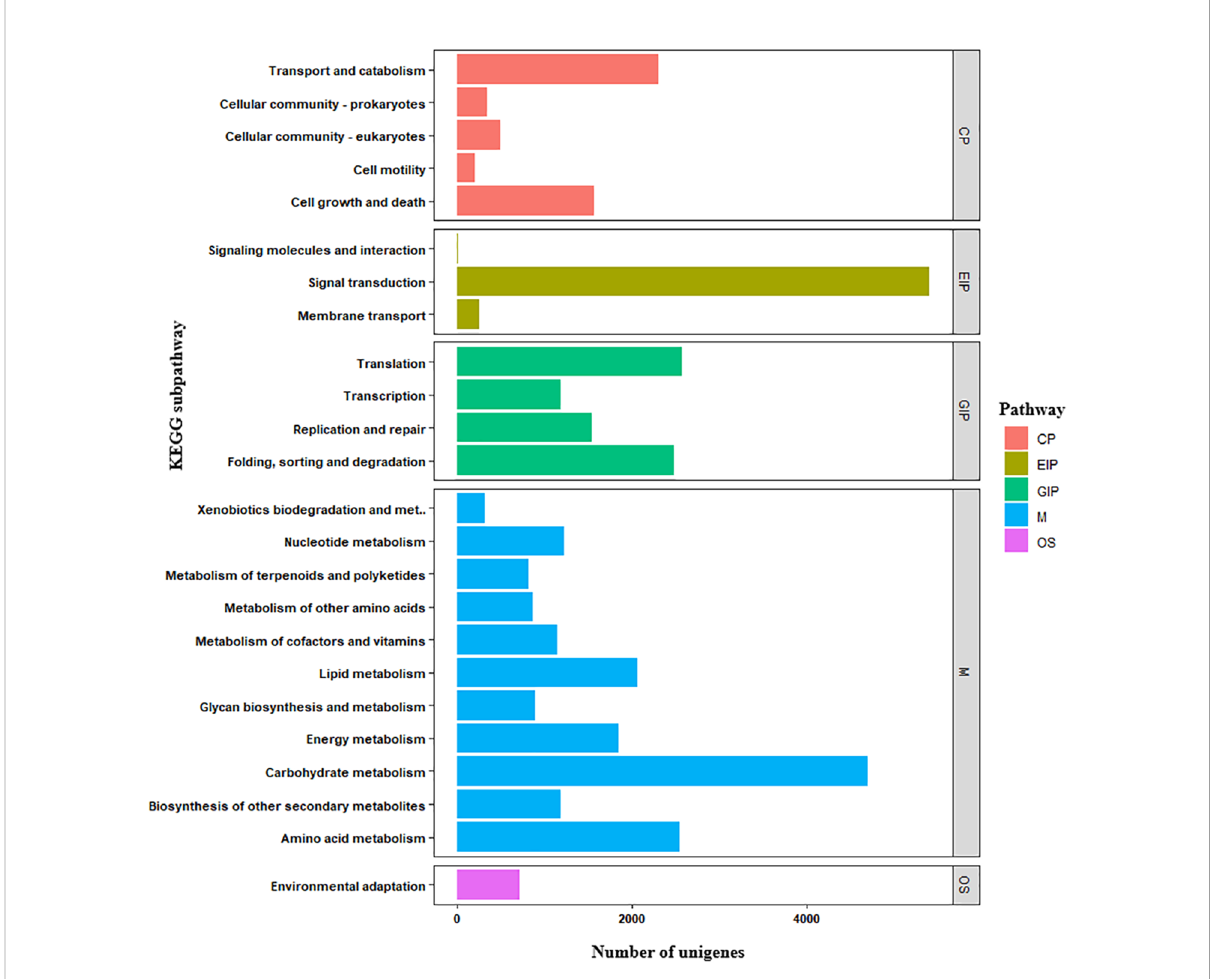
FIGURE 5 Kyoto Encyclopedia of Genes and Genomes (KEGG) annotation of fi nger millet unigenes in to different pathway categories. X-axis indicates number of unigenes and Y-axis indicates KEGG sub-pathways.